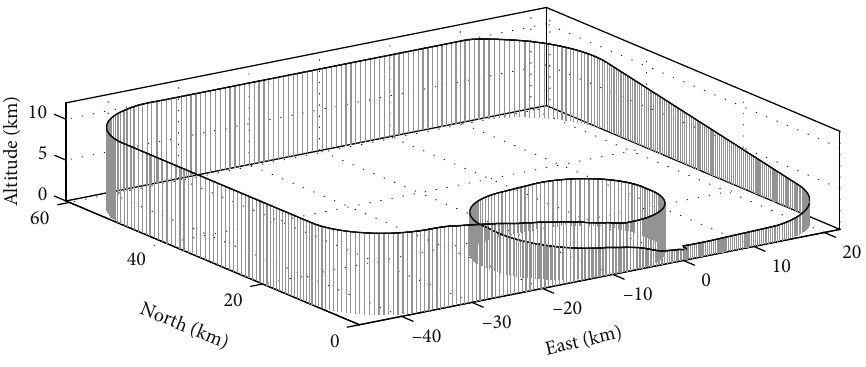
Figure 18: Flight trajectory of the